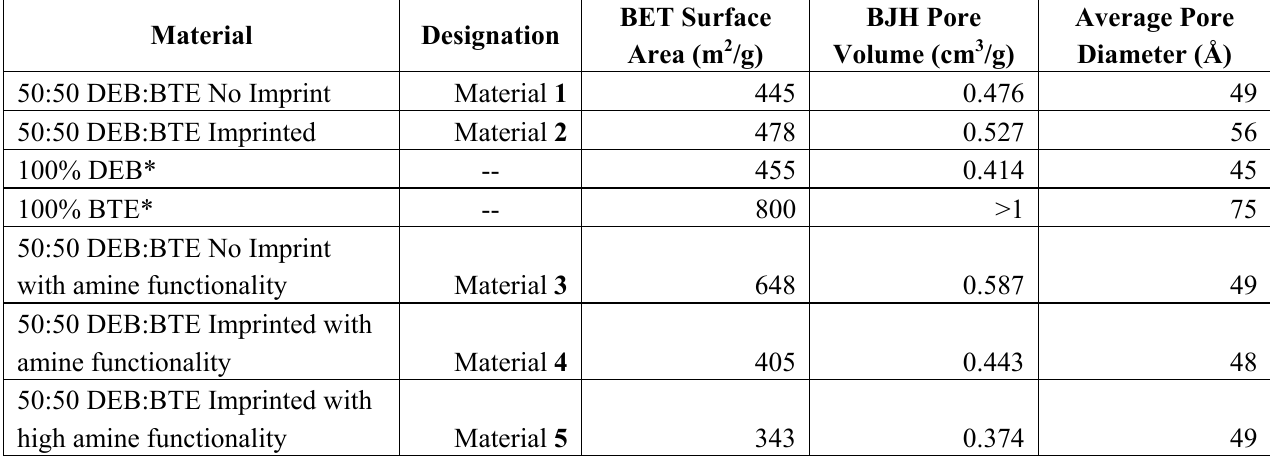
Table 2. Material Characteristics.